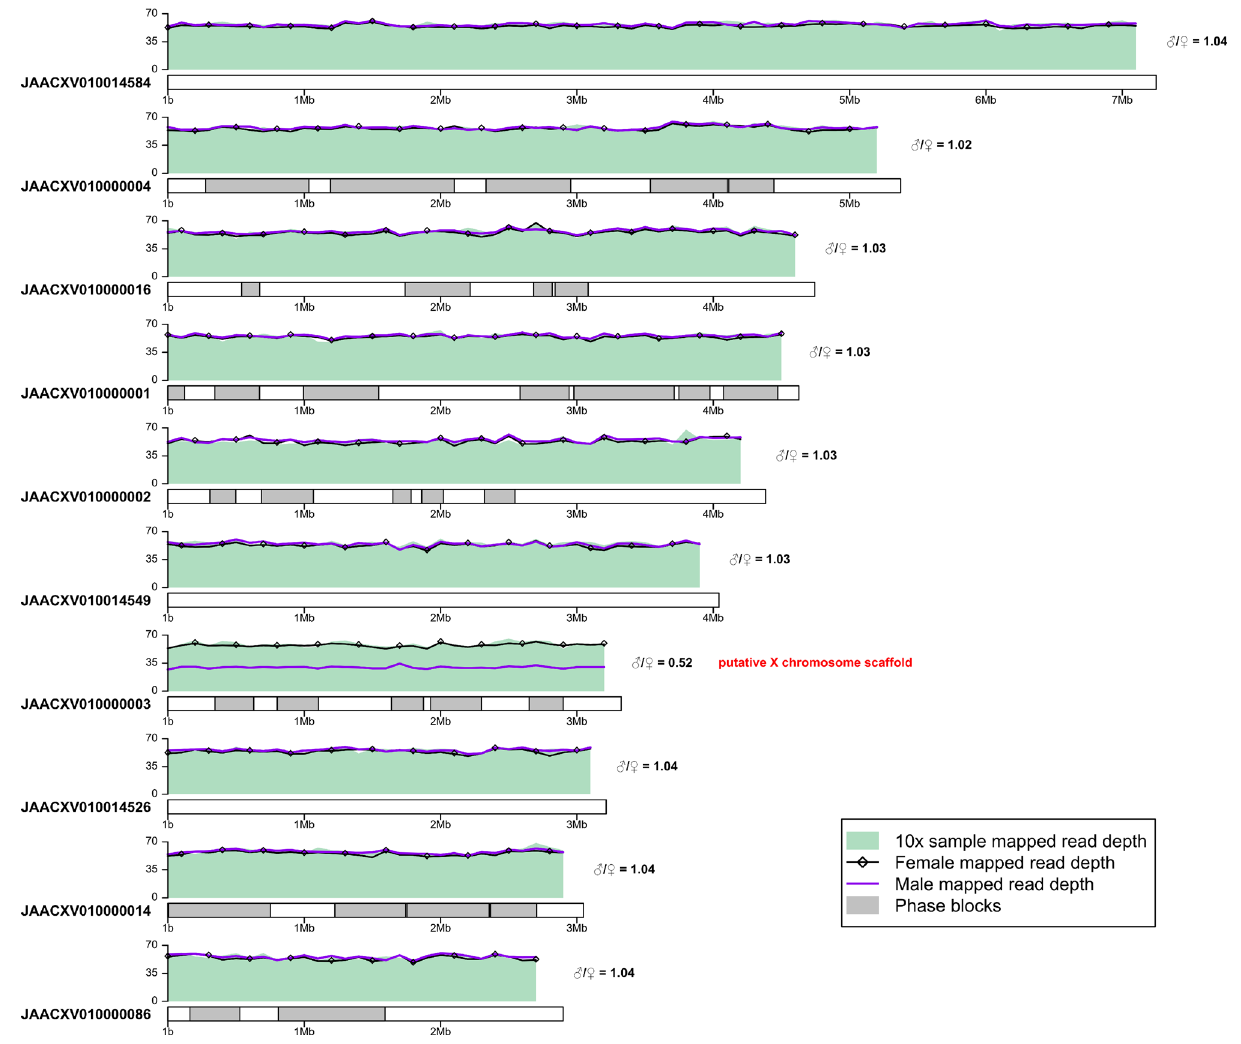
Figure 2. Identification of putative sex chromosome scaffolds. Sequencing data were subsampled to ∼ 39 Gb and mapped to pseudo-haplotype1. Mean mapped read depth of the 10x Genomics reads produced in this study (SRX7520800; green shaded area), and the female (black line with open diamonds) and male (purple line) Illumina reads from Hazzouri et al. 18 (SRX5416728 and SRX5416729) is shown in 100 kb windows across the 10 longest scaffolds of pseudo-haplotype1 assembly with terminal windows removed. Phase blocks are shown as gray rectangles. The ratio of male/female mean mapped read depth is given on the right side of each scaffold. Scaffolds with a male/female ratio of ∼ 0.5 are indicated as putative sex chromosome sequences. The similar mapped read depth of our RPW sample and the female sample from Hazzouri et al., as well as the presence of phase blocks on putative sex chromosome scaffolds implies heterozygosity due to diploidy and indicates that such scaffolds are X-linked and that the individual sequenced in this study is